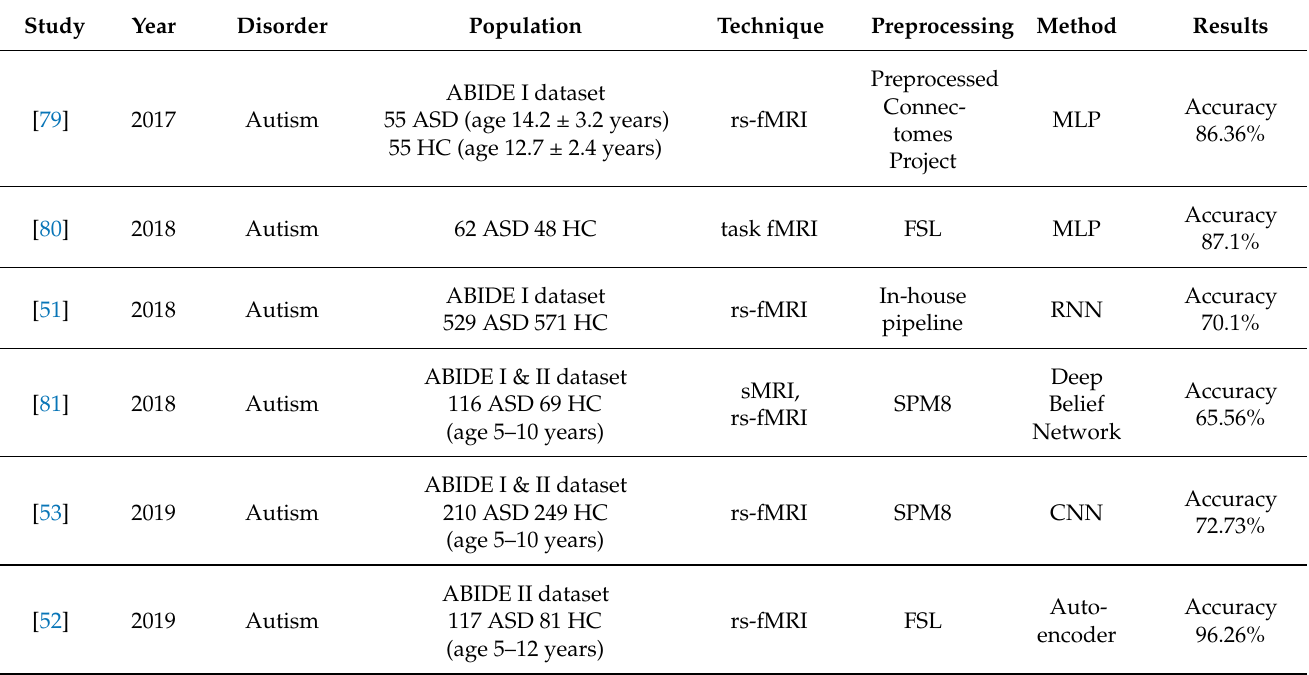
Table 2. Recognizing neurodevelopmental